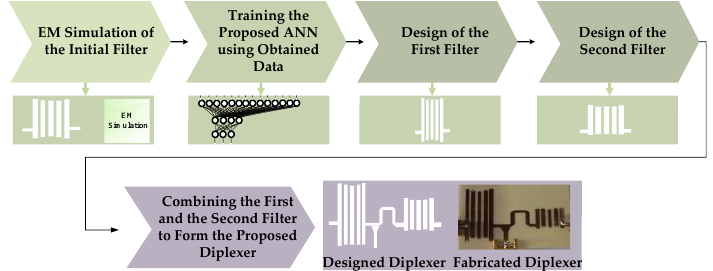
Figure 2. The design procedures of the proposed diplexer.